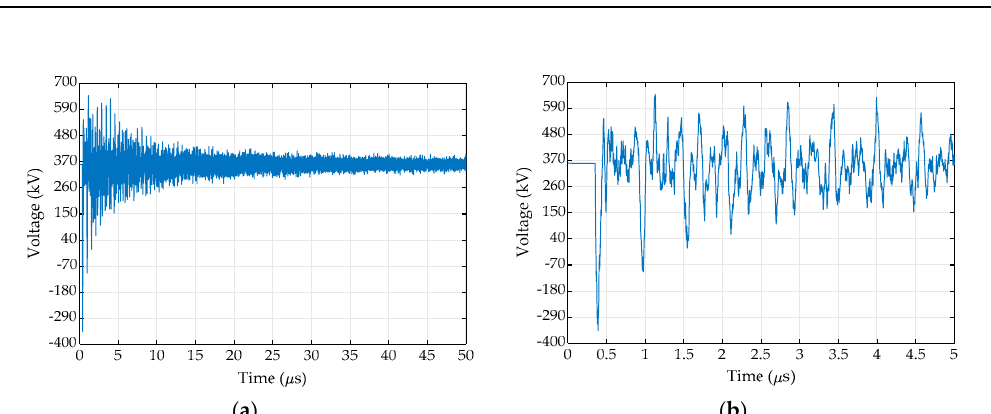
Figure 10. Voltage at gas-air bushing for circuit-based model: ( a ) 50 μ s duration; and ( b ) magnified 5 μ s.